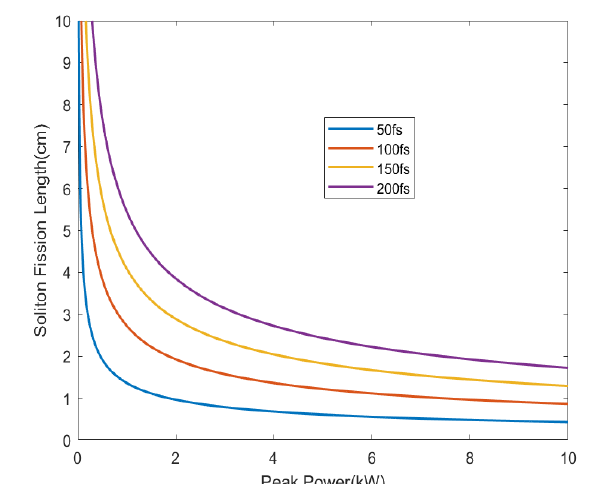
Figure 8: Soliton fission length at different input